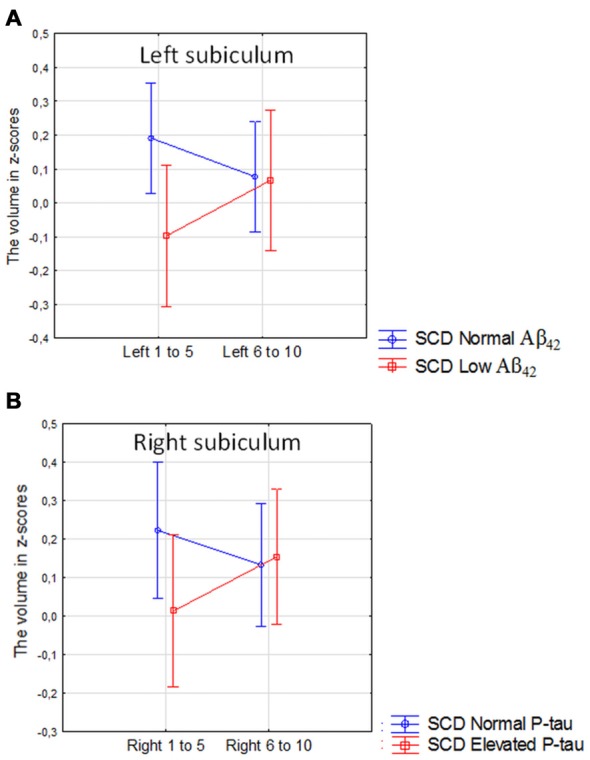
SCD with normal vs. SCD with low CSF Aβ42 or elevated P-tau. The figure denotes the interaction between high vs. low levels of CSF Aβ42 and the anterior vs. posterior 50% of the left subicular subfield (A), and the interaction between high vs. low P-tau levels and the anterior vs. posterior 50% of the right subicular subfield (B). Blue line, normal CSF levels, red line, abnormal CSF levels. Vertical bars denote 95% confidence interval.